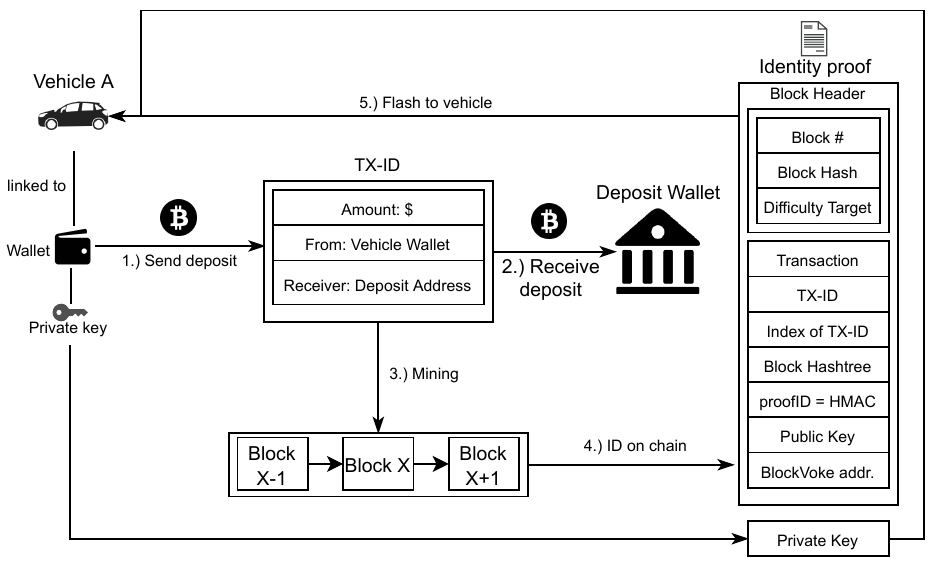
Figure 2. Creating a new identity proof—based on